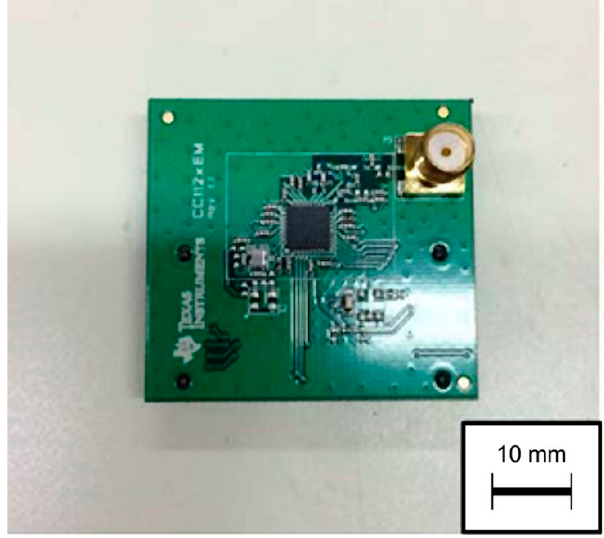
Figure 2. Compact single-chip wireless communication module.